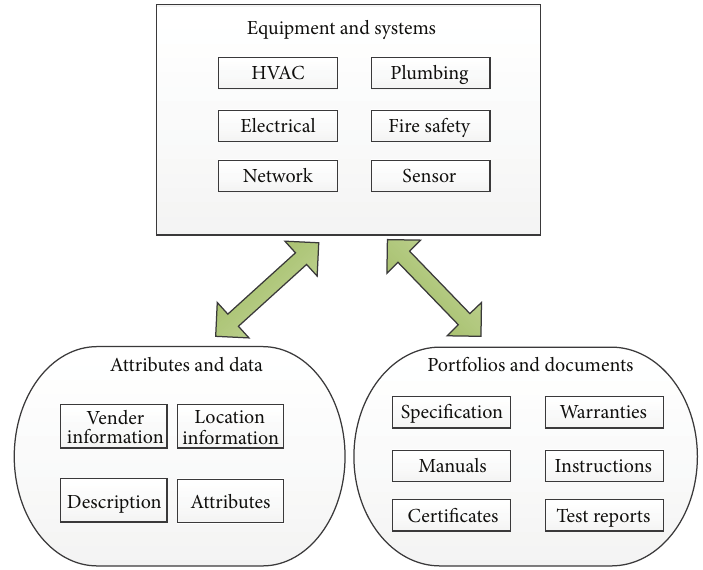
Figure 3: FM based BIM